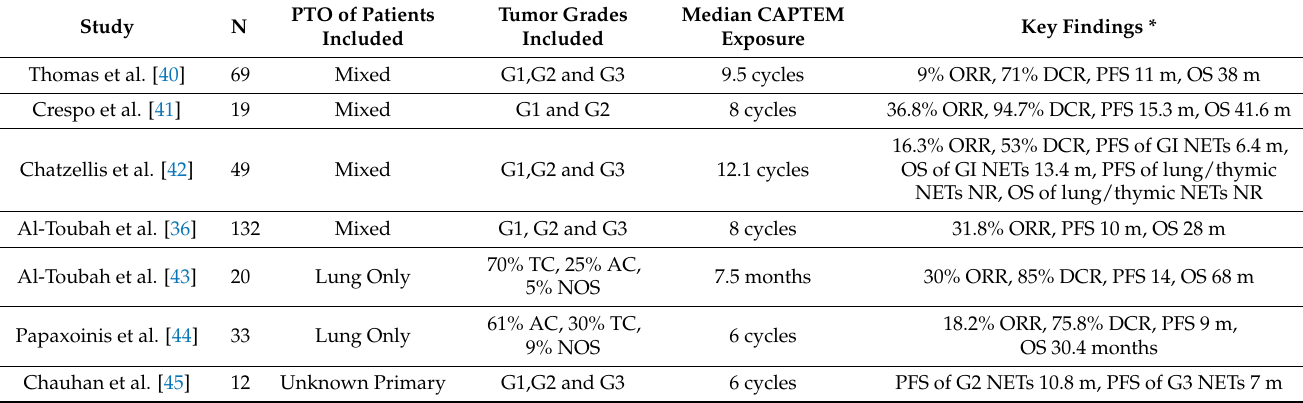
Table 2. A summary of retrospective studies in patients with extra-pancreatic NETs treated with capecitabine plus temozolomide. Study N Key Findings